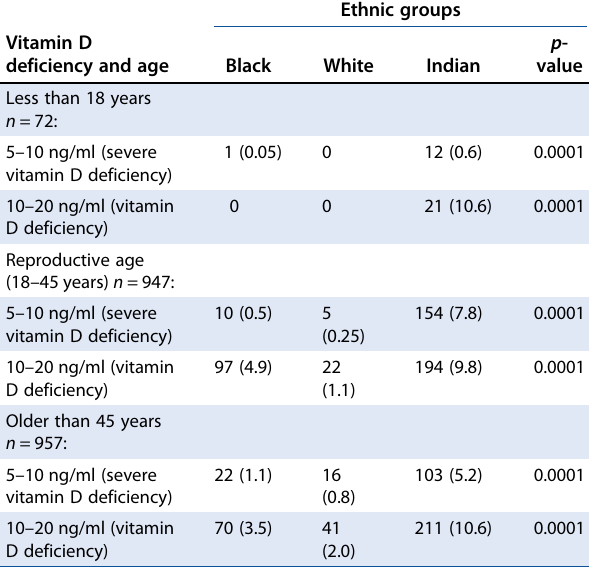
Table 3: Vitamin D deficiency, ethnicity and age